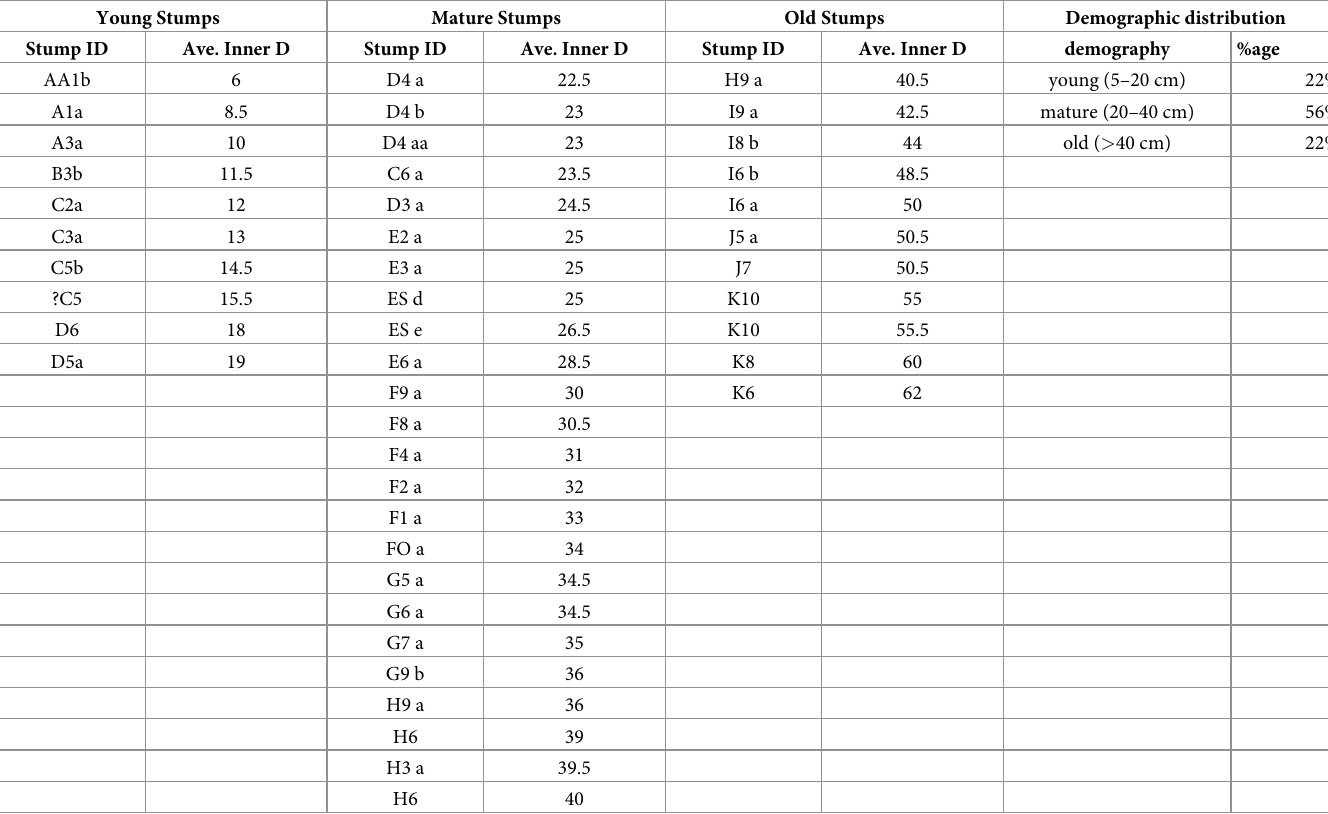
Table 1. Demographic distributions of the Eospermatopteris trees at the Gilboa Riverside Quarry (After Stein et al., 2012). Young